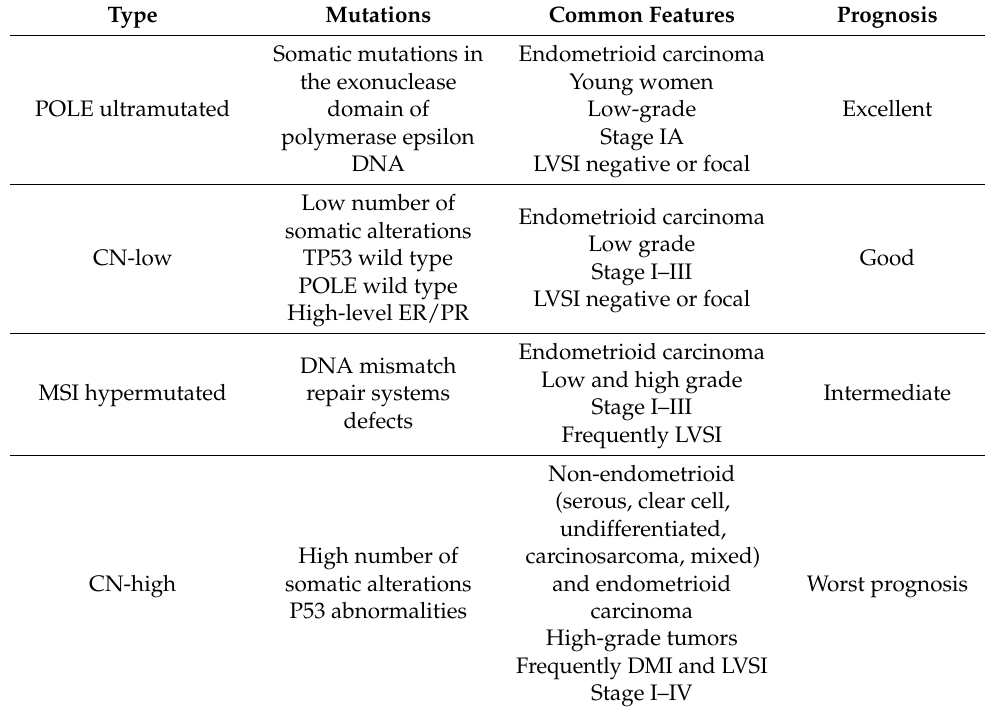
Table 1. Principal characteristics of molecular